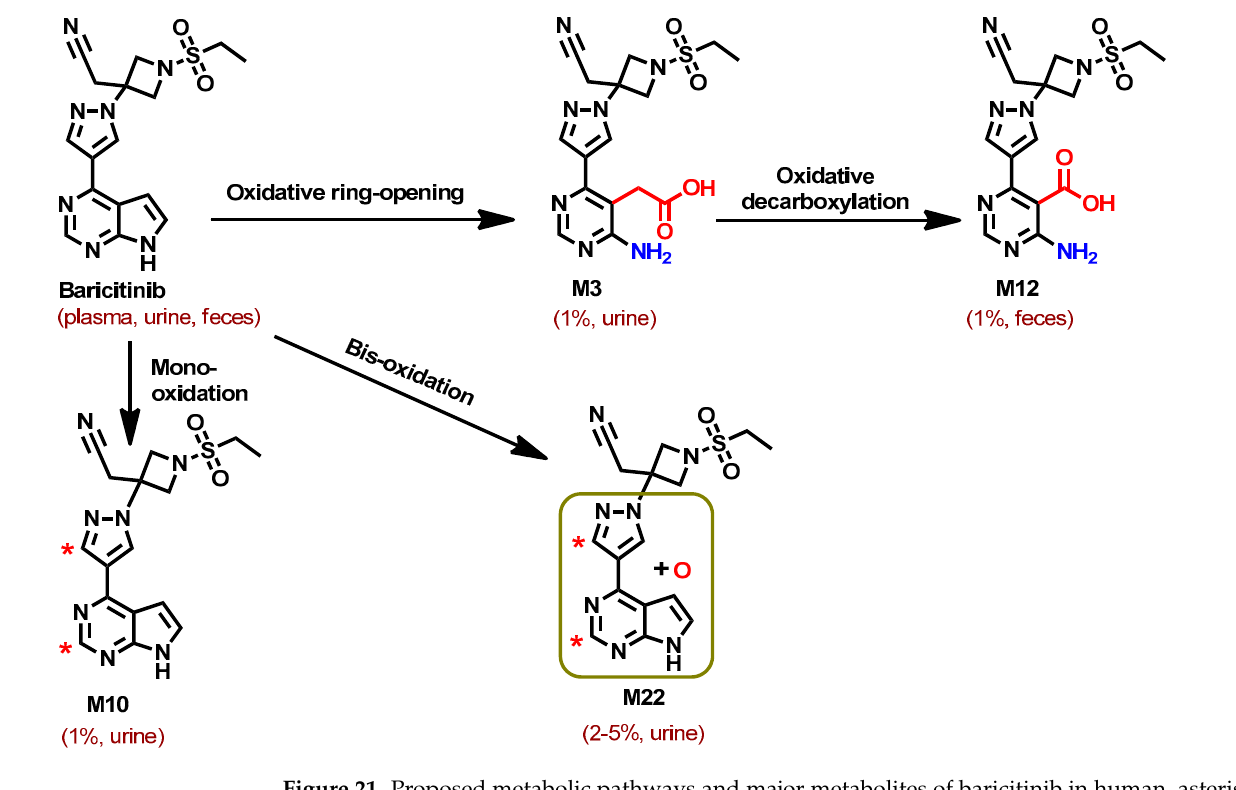
Figure 21. Proposed metabolic pathways and major metabolites of baricitinib in human, asterisks indicate the sites of oxidation.